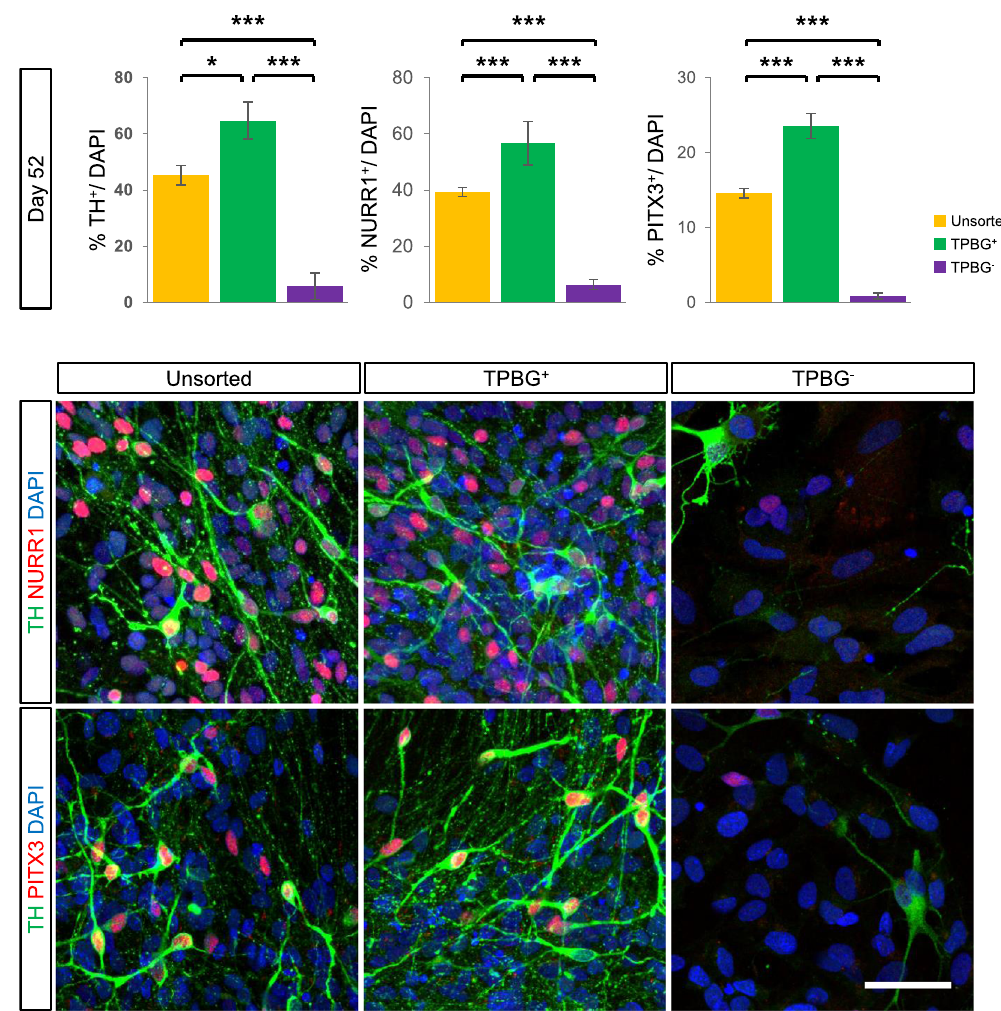
Fig. 4 Terminal differentiation of TPBG + cells. Quanti fi cation of TH + , NURR1 + , and PITX3 + cells after terminal differentiation of unsorted, TPBG + , and TPBG − cells on D52. Data are shown as mean ± SD of nine independent experiments. * p < 0.05, ** p < 0.01, *** p < 0.001, one-way ANOVA with Bonferroni ’ s multiple-comparison tests ( top ). TH (green), NURR1 (red), and PITX3 (red) were analyzed by immuno fl uorescence staining in terminally differentiated unsorted, TPBG + , and TPBG − cells on D52. DAPI (blue) detected total cell populations. Scale bar, 50 μ